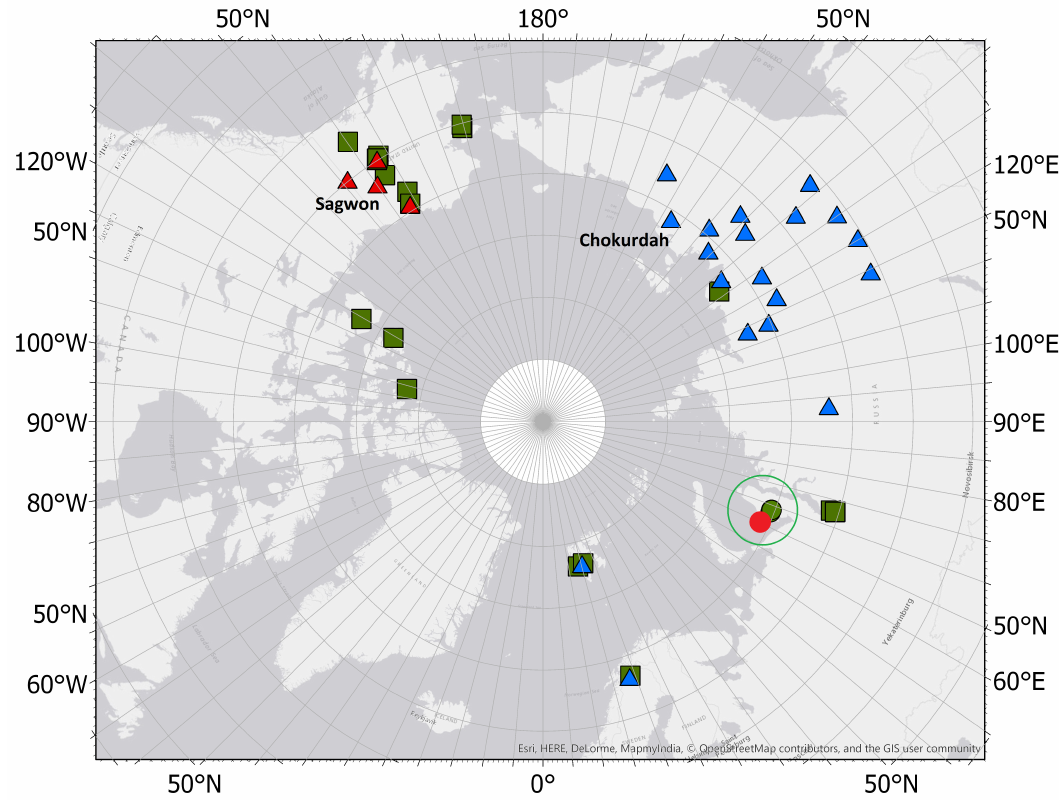
Figure 2. Overview of the studied sites for air temperature and snow depth dependency analysis of World Meteorological Organization (WMO) (blue triangle, air temperature and snow depth) and Snow Telemetry (SNOTEL) (red triangle, air temperature and snow depth) measurement sites; and the ground temperature dependency analysis of used GTN–P boreholes (green square, ground temperature) and boreholes from the Vaskiny Dachi research station on Central Yamal (green dots plus highlighted by green circle, ground temperature). The red circle marks the location of WMO station Marre Sale (Yamal, Russia), which is later used as a